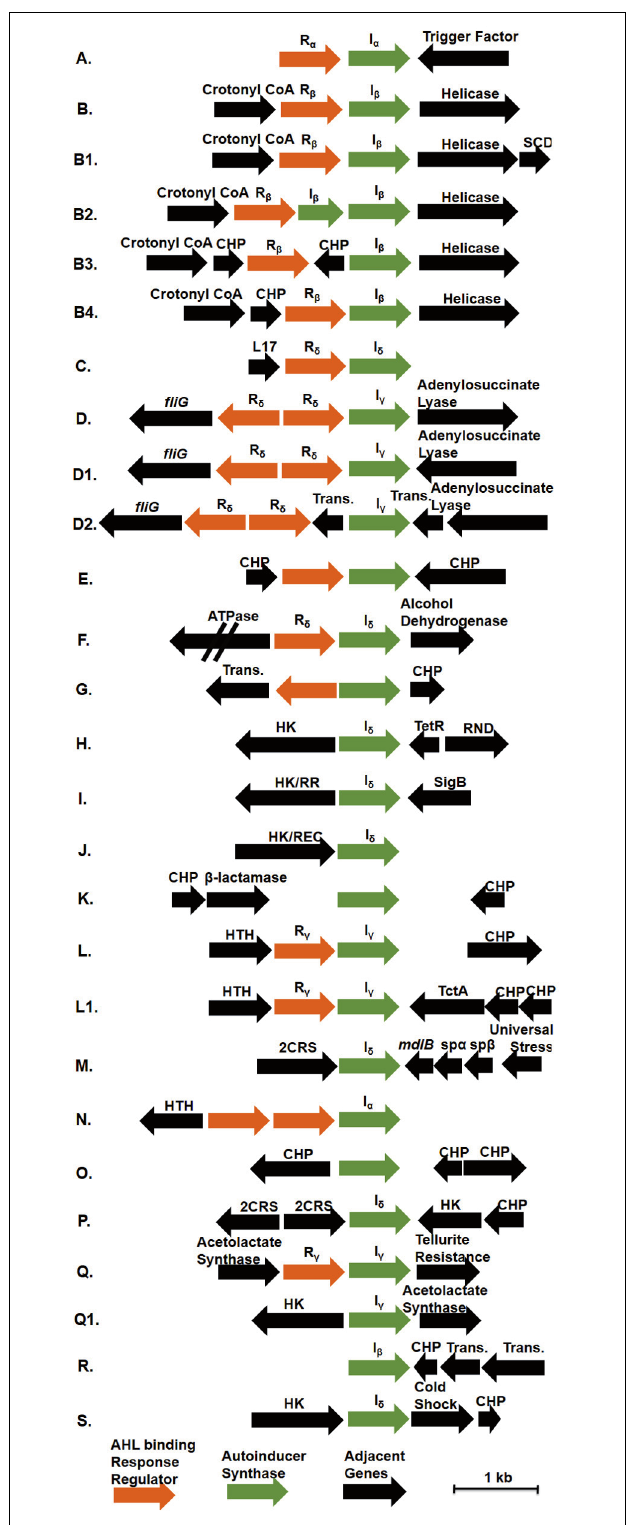
FIGURE 2 | The gene orientation of all putative luxRI operons in available Roseobacter genomes. Green arrows represent AHL synthase encoding genes ( luxI ), orange arrows represent AHL binding response regulators ( luxR ), and black arrows represent adjacent genes. Abbreviations used: Crotonyl CoA, Crotonyl CoA reductase; HK, histidine kinase; HK/RR, hybrid histidine kinase/response regulator; HK/REC, histidine kinase with REC domain; CHP, conserved hypothetical protein; RND, RND multidrug efflux pump; Sig B, sigma B factor; SCD, short chain dehydrogenase; Trans., transposase; L17, L17 component of the 50S ribosomal protein; 2CRS, two-component regulatory system; TctA, TctA family transmembrane transporter; mdlB, mandelate dehydrogenase mdlB ; sp αβ , α and β subunits of sulfopyruvate decarboxylase. R x and I x designations above the response regulators and AHL synthases indicate their corresponding phylogentic subgroupings in Figures 1A,B , respectively. Those without R x and I x designations indicate unique sequences not found in the conserved groupings. The corresponding genomes that contain these topologies can be found in Table A1